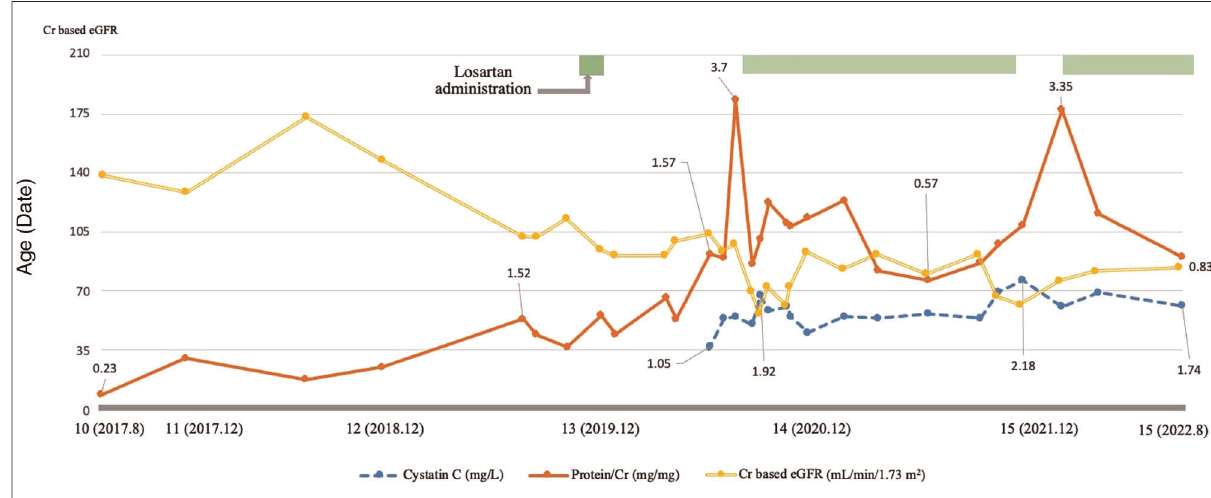
FIGURE 2 Characteristics of the patient during the follow-up. This graph shows the patient ’ s trend of proteinuria and creatinine-based estimated glomerular fi ltration rate (eGFR) and cystatin C levels during the follow-up. Proteinuria is indicated using a solid line, cystatin C using a dashed line, and creatinine-based eGFR using a double line. The patient ’ s proteinuria and kidney function waxed and waned during the follow-up, and following the administration of losartan, his proteinuria and renal function improved and remains stationary. Creatinine based eGFR (ml/min/1.73 m 2 ), Cystatin C (mg/L), Protein/Cr